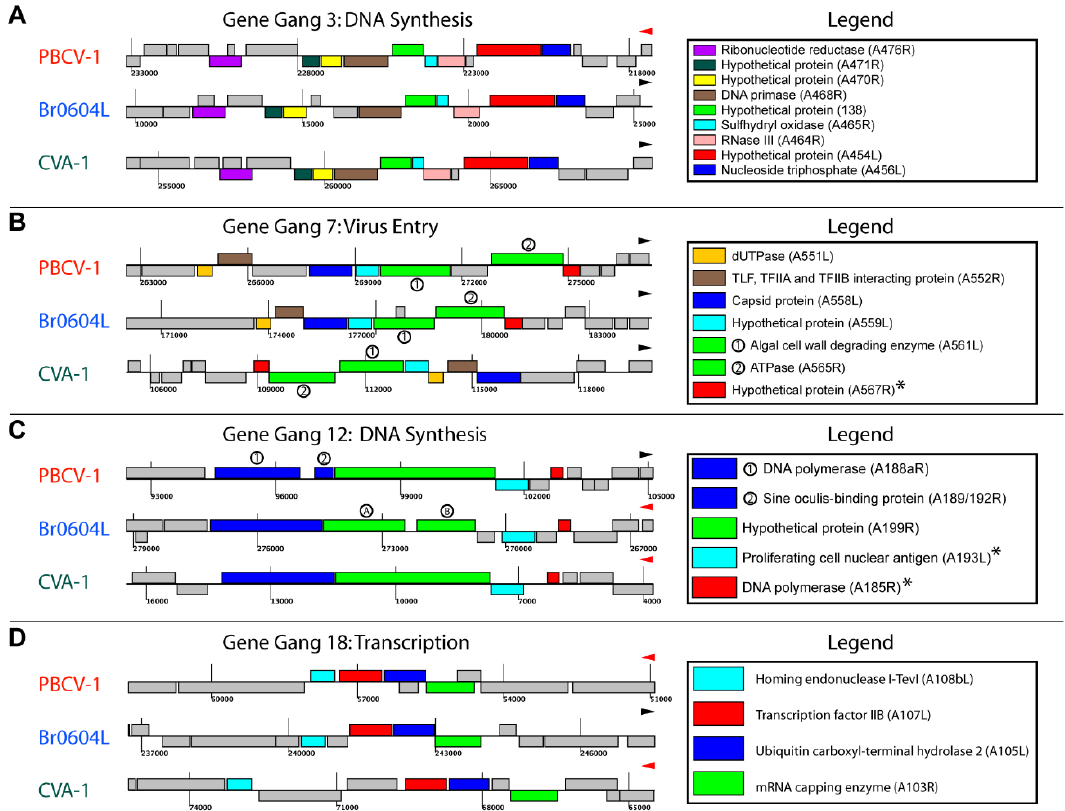
Figure 4. Topological features of four selected gene gangs ( A–D ). Genomic groupings are shown for a sample virus species associated with each host type (PBCV-1 from NC64A, Br0604L from SAG, and CVA-1 from Pbi). Gang members are indicated as colored genes, while surrounding non-gang member genes are shown in gray. Coordinates for each genome are given, as well as a black or red triangle to indicate increasing coordinate direction. In each genomic segment, genes above the center line are transcribed in the direction the triangle is pointing, while genes below the center line are transcribed in the direction opposite of the facing triangle. Each color refers to a different cross-species protein homology group. Annotations for each homology group, as well as the PBCV-1 gene ID, are provided in the legend to the right of each gene gang. If multiple paralogs were identified for a given homology group within a genomic grouping, paralogs are distinguished with circled numbers on the genomic groupings and legend ( B and C ). If a gene has been segmented into two parts by a probable insertion event or intron, the segmented parts of the gene are distinguished with a circled A and B ( C ). Annotations marked with no asterisk were associated in that genome for all 41 chloroviruses (ruly), while annotations marked with an asterisk were identified in 37 or more of the 41 chloroviruses, but not all 41 chloroviruses (unruly). Table 2. Chlorovirus gene gangs — conservation of gene content, synteny, strandedness, and the frequency of alien gene infiltration.